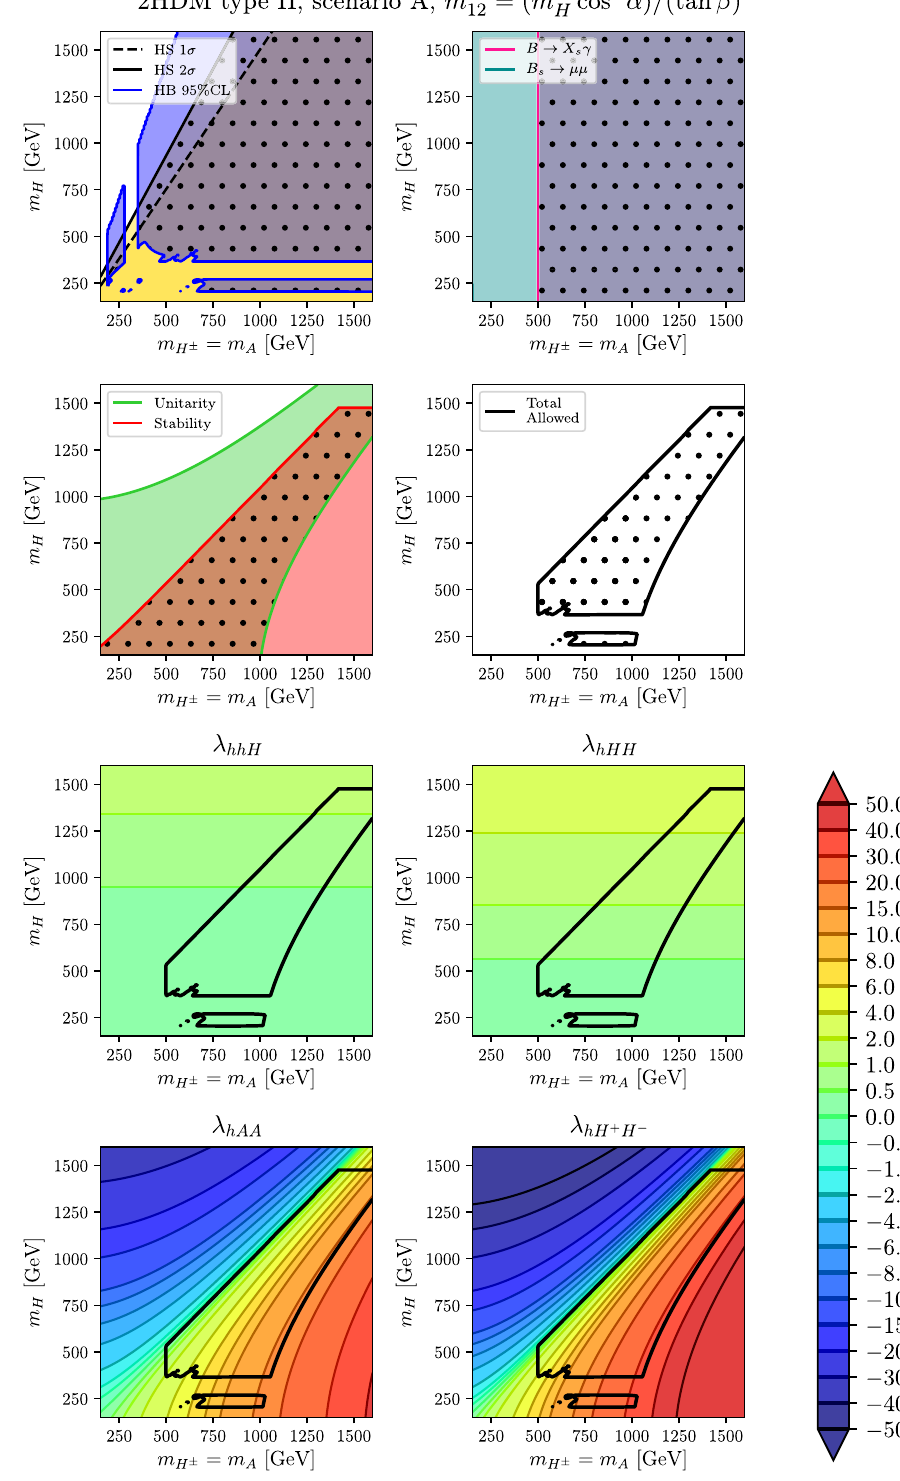
Fig. 17 Predictions for triple Higgs couplings in the 2HDM type II, scenarioA,inthe ( m H ± = m A , m H ) planewith c β − α = 0 . 025,tan β = = ( m 2 6 . 5 and m 2 cos 2 α)/( tan β) . Upper four plots: allowed regions H 12